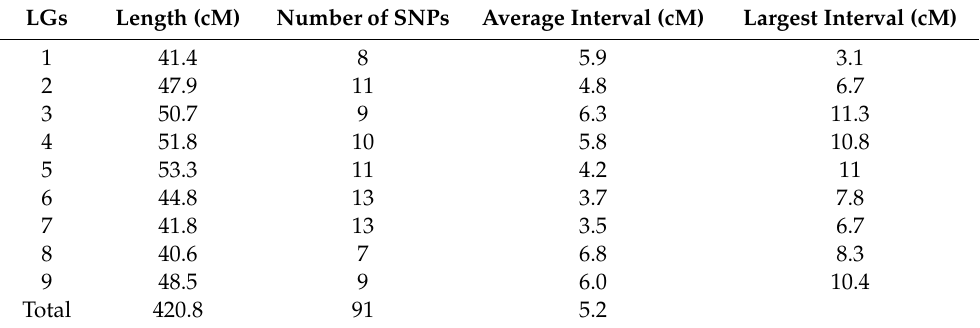
Table 2. Length, number of markers, average spacing, and largest intervals of GX71 genetic maps. LGs